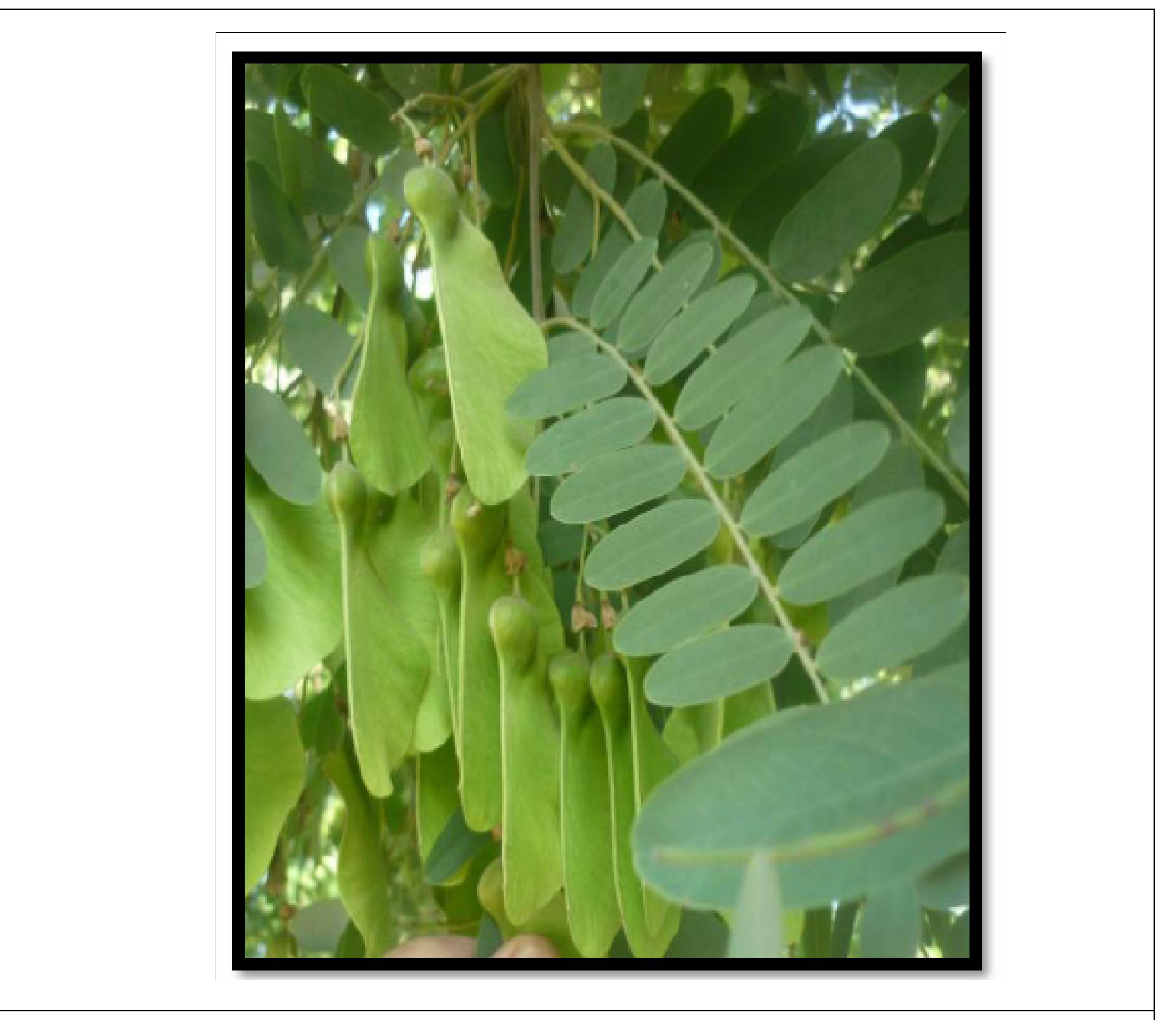
Figure 2. Leaves and legumes of T. speciosa